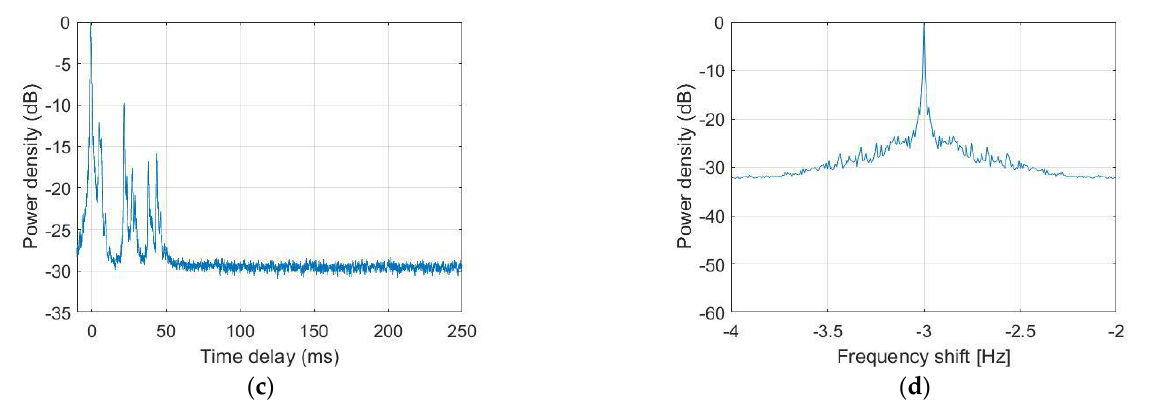
Figure 12. Underwater channel characteristics in the sea trial: ( a ) channel impulse response, ( b ) scattering function, ( c ) power delay profile, and ( d ) Doppler power spectrum.